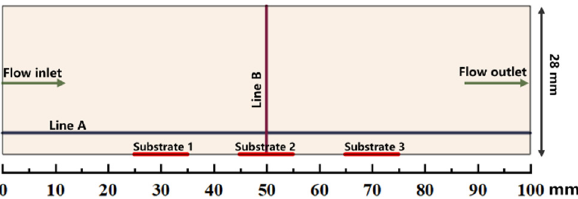
Figure 1. Schematic illustration of the computational gas phase domain above the